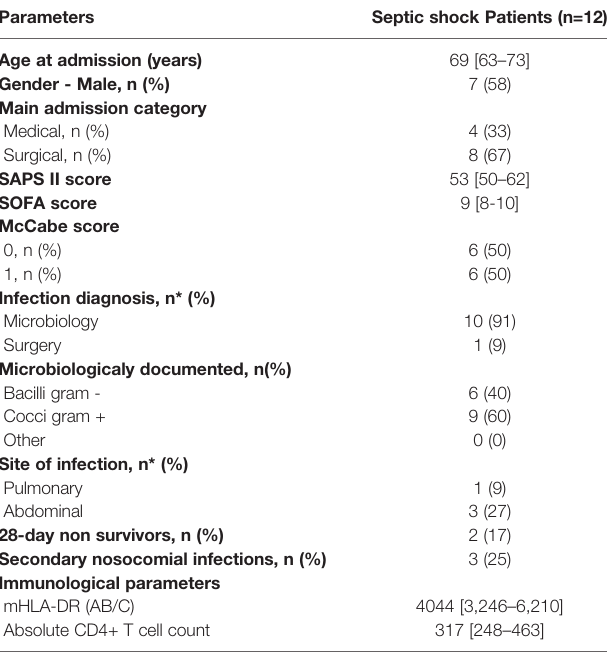
expressing cells after stimulation. B lymphocytes, CD4+ T cells TABLE 1 | Demographic, clinical, and immunological data for septic shock patients.